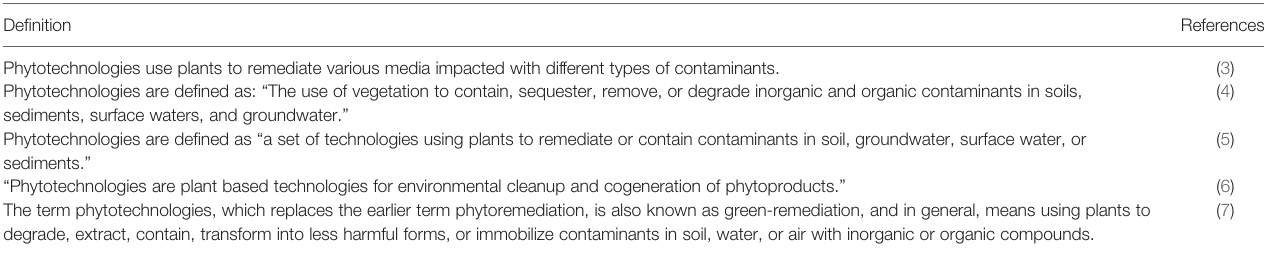
TABLE 1 | De fi nitions of phytotechnologies encountered in the literature. De fi